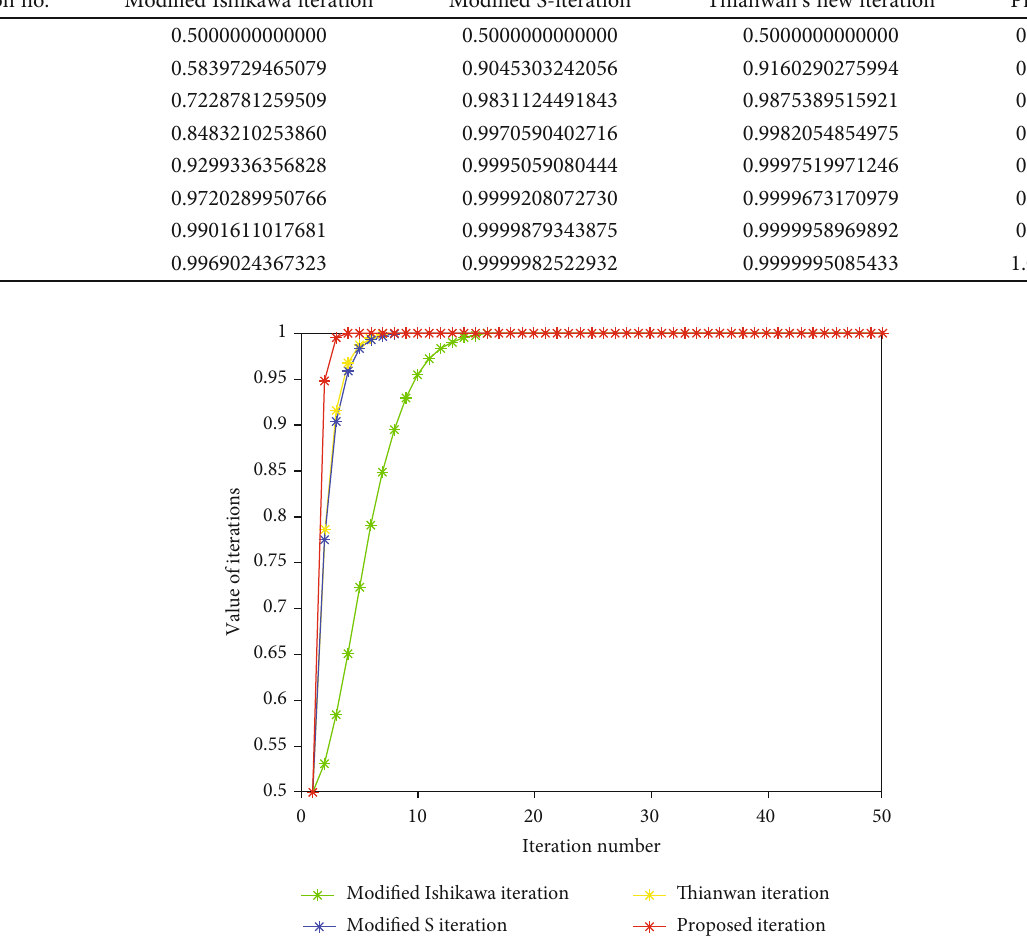
Figure 1: Numerical experiment of Example 1 using the modi fi ed Ishikawa iteration, modi fi ed S-iteration, Thianwan new iteration, and proposed